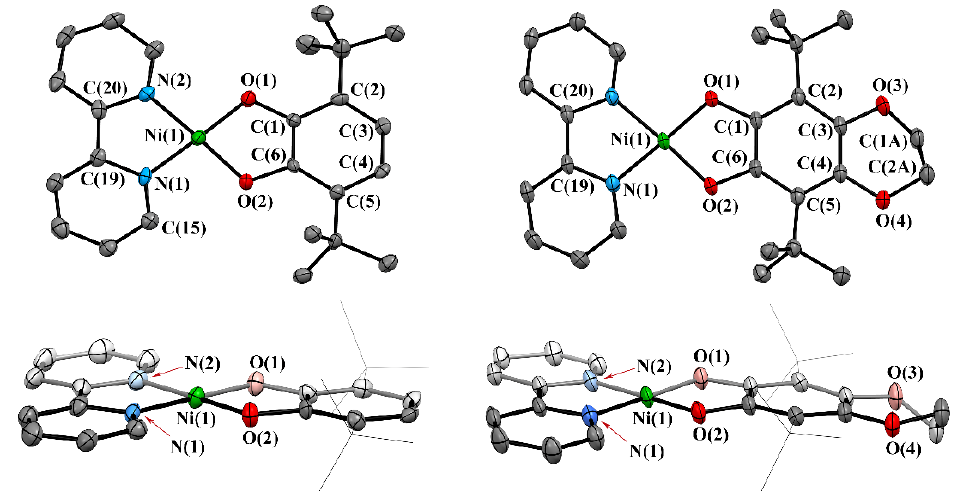
Figure 1. Views of 1 (left) and 2 (right) molecular structures with 50% thermal probability ellipsoids. Hydrogen atoms are omitted for clarity.